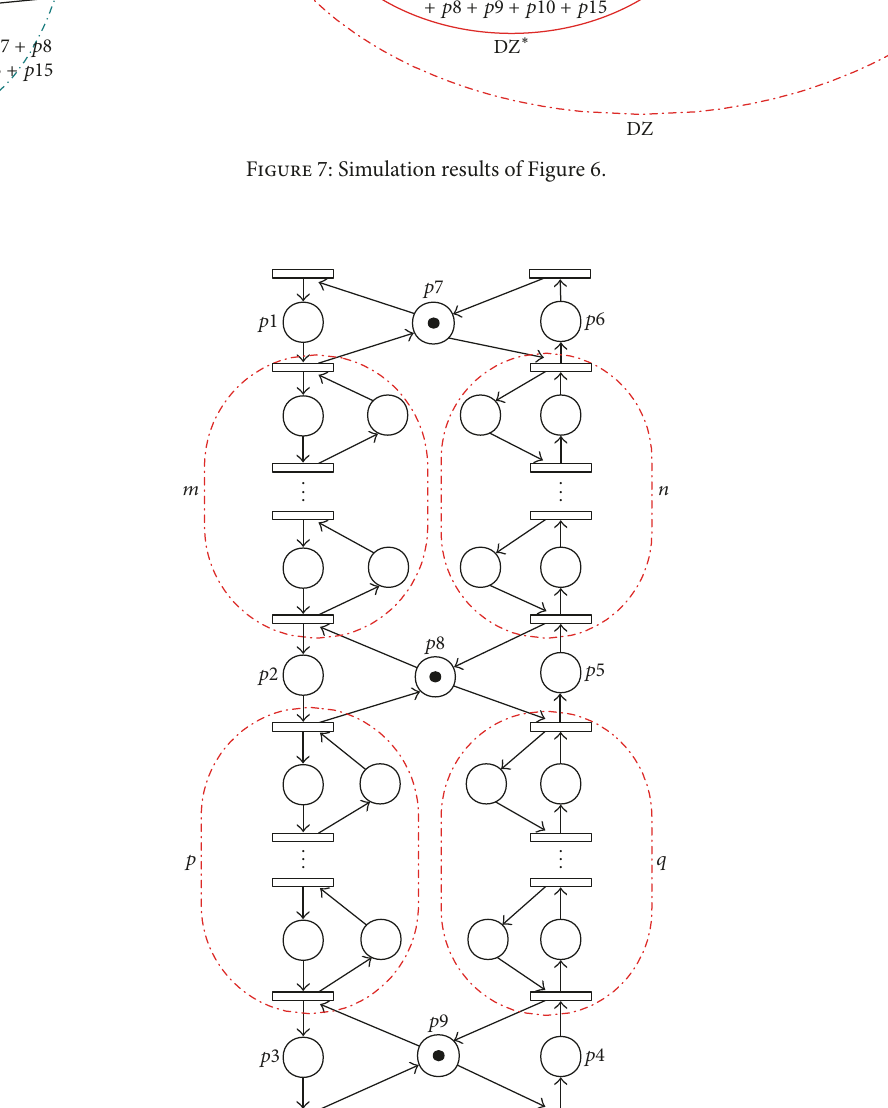
Figure 8: A 𝑘 -step look-ahead S 3 PR